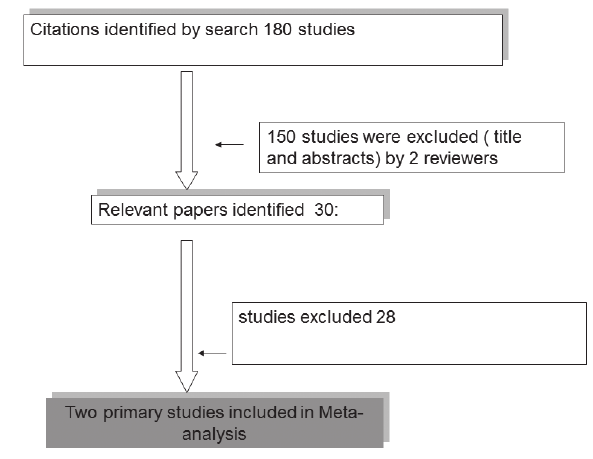
Figure 1 - Study selection process.